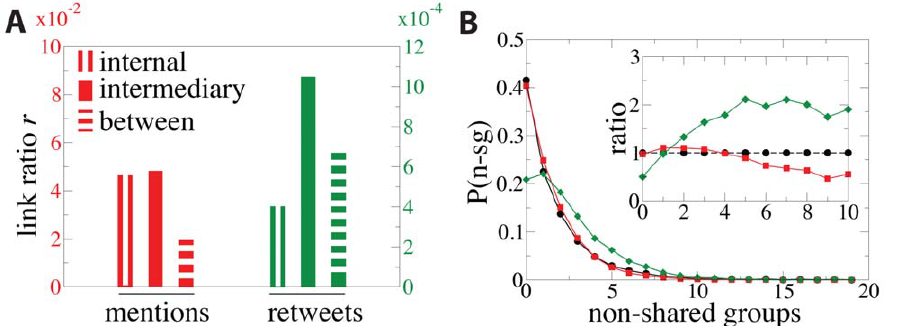
Figure 5. Intermediary links. (A) Ratio r between the number of links with mentions or retweets and number of follower links. (B) Distribution of the links in the follower network (black curve), those with mentions (red curve) and retweets (green curve) as a function of the number of non-shared groups of the users connected by the link. Inset, ratios between these distributions and the follower network.